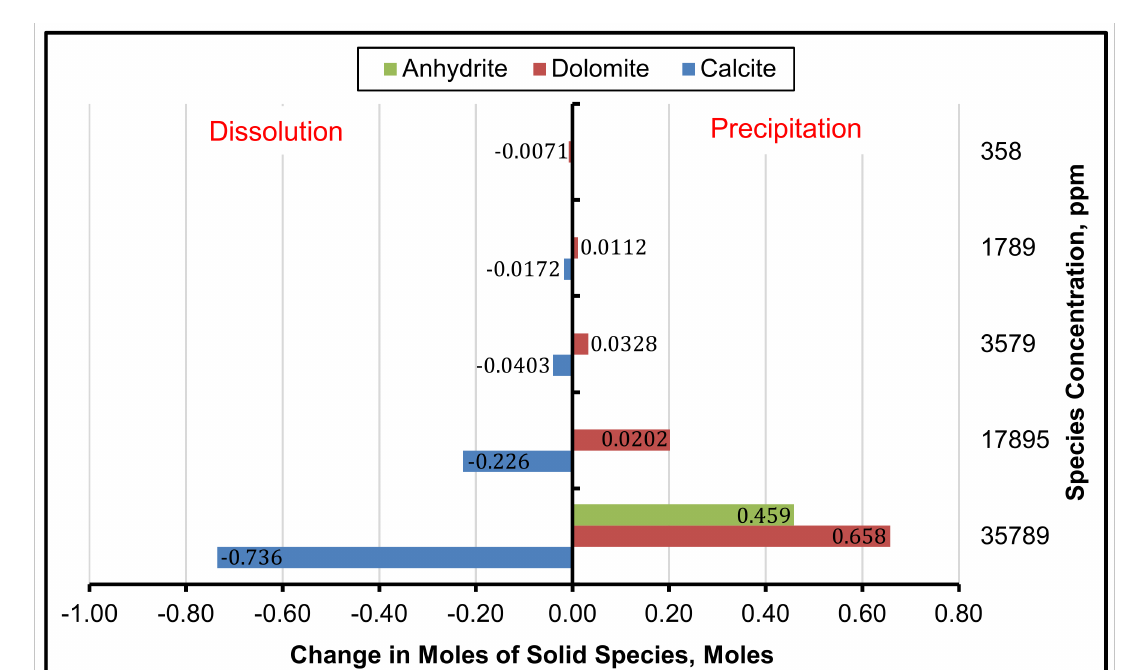
Figure 11. Effect of water dilution on solid species for the first gridblock at 6 PVs with formation and injected water temperatures fixed at 200 ◦ C and 100 ◦ C,